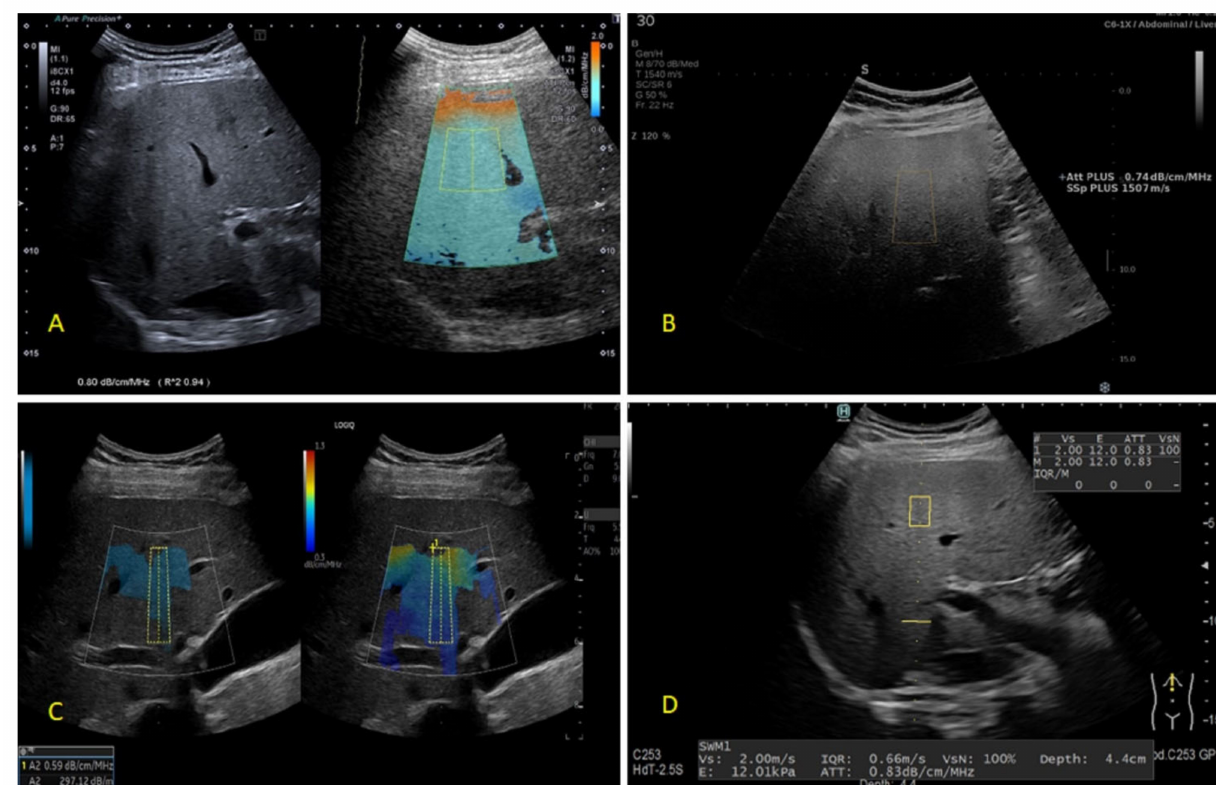
Figure 1. Images of liver steatosis quantified using different ultrasound-based methods: ( A ) at- tenuation imaging (Canon); ( B ) attenuation plane-wave ultrasound and sound speed plane-wave ultrasound (Hologic); ( C ) ultrasound-guided attenuation parameter (General Electric); ( D ) attenua- tion measurement function